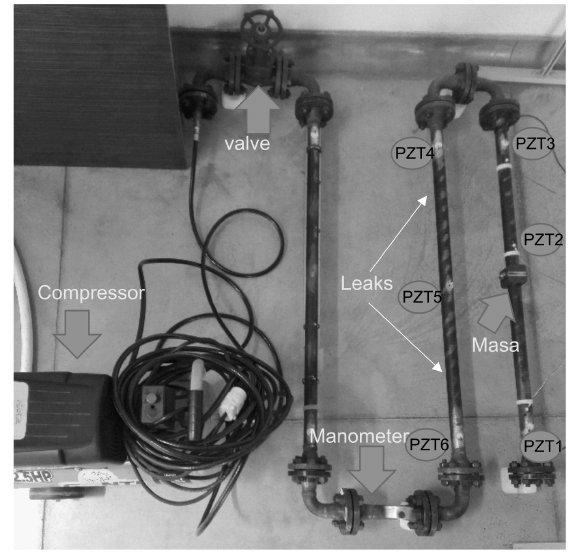
Figure 14. Pipe loop